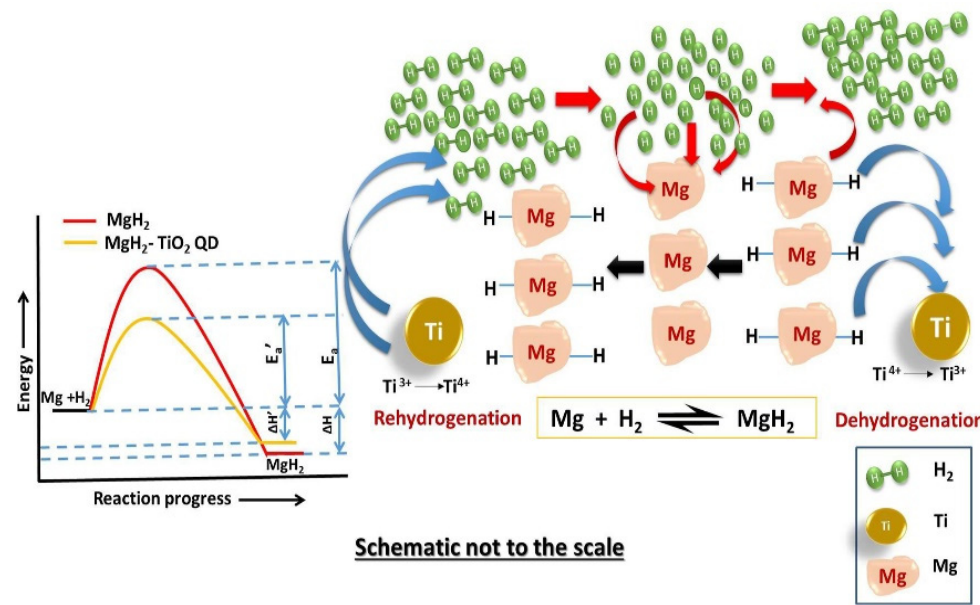
Figure 9. Schematic diagram depicting multiple valencies of Ti in TiO 2 :QDs during dehydrogena- tion and rehydrogenation of MgH 2 +TiO 2 :QDs sample. Copyright 2021, Elsevier. Reproduced with permission from [99].